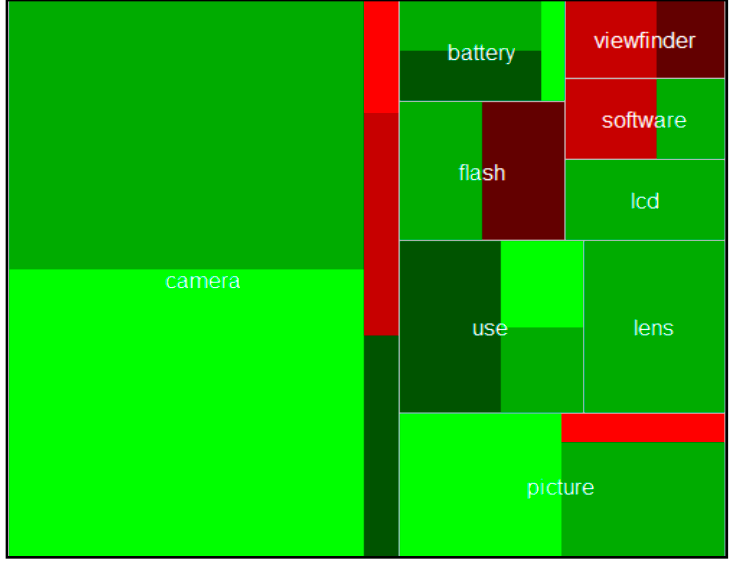
Figure 15. Proposed Tree Map Visualization of Digital Camera 1.